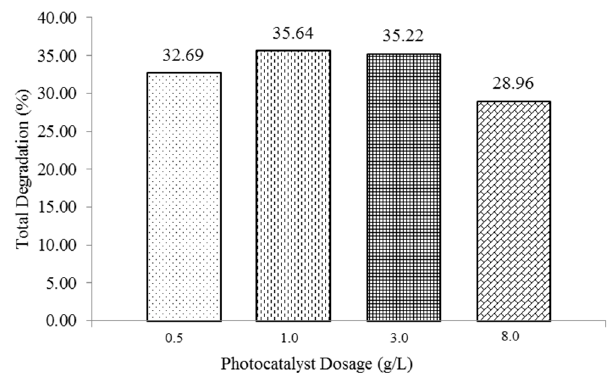
Figure 8. Efficiency of [bmim]Cl degradation system at different [photocatalyst].